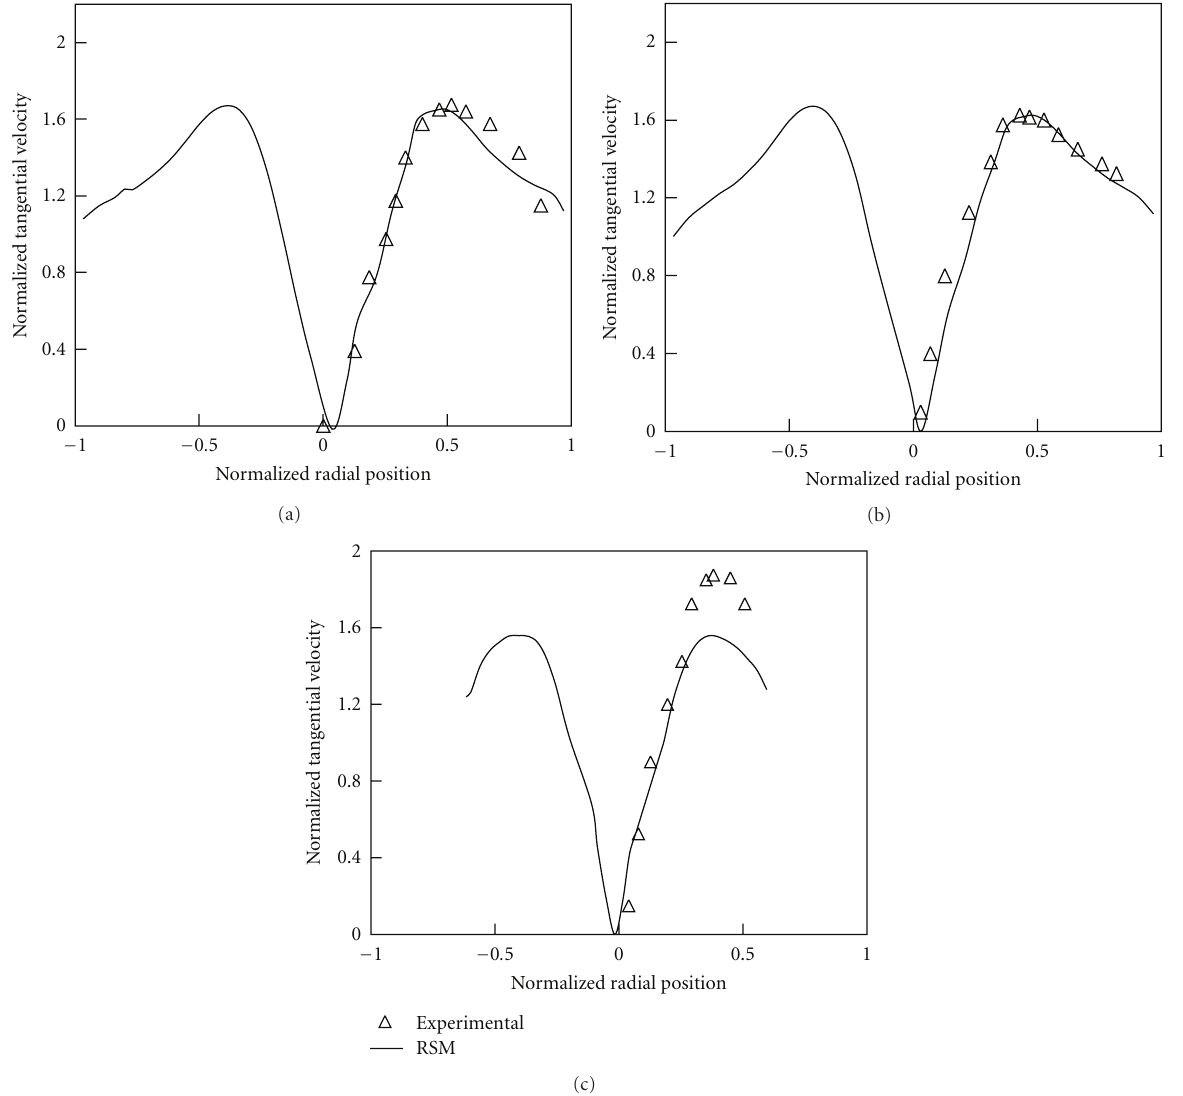
Figure 4: Radial profiles of the tangential velocity (a) and (b) in the swirl chamber, (c) in the conical part (experimental results from